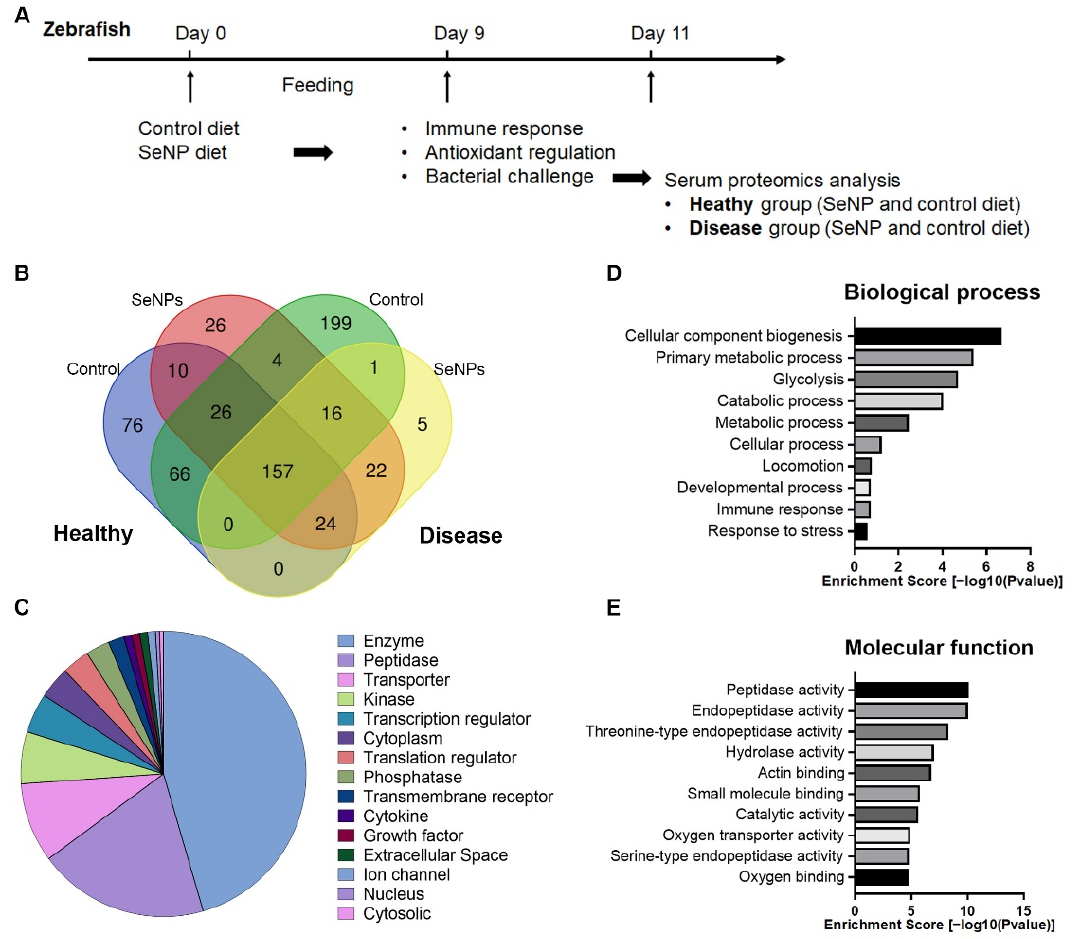
Figure 3. Serum proteomic analysis with/without dietary SeNPs in healthy and diseased conditions: ( A ) Experimental scheme of serum proteomic analysis; ( B ) Venn diagram depicting the total number of identified protein families in zebrafish serum from the control diet and SeNP diet in healthy conditions and control diet and SeNP diet in diseased condition. ( C ) Protein type category by IPA classification; ( D ) GO term biological processes analysis of serum proteins; ( E ) GO term molecular functions analysis of serum